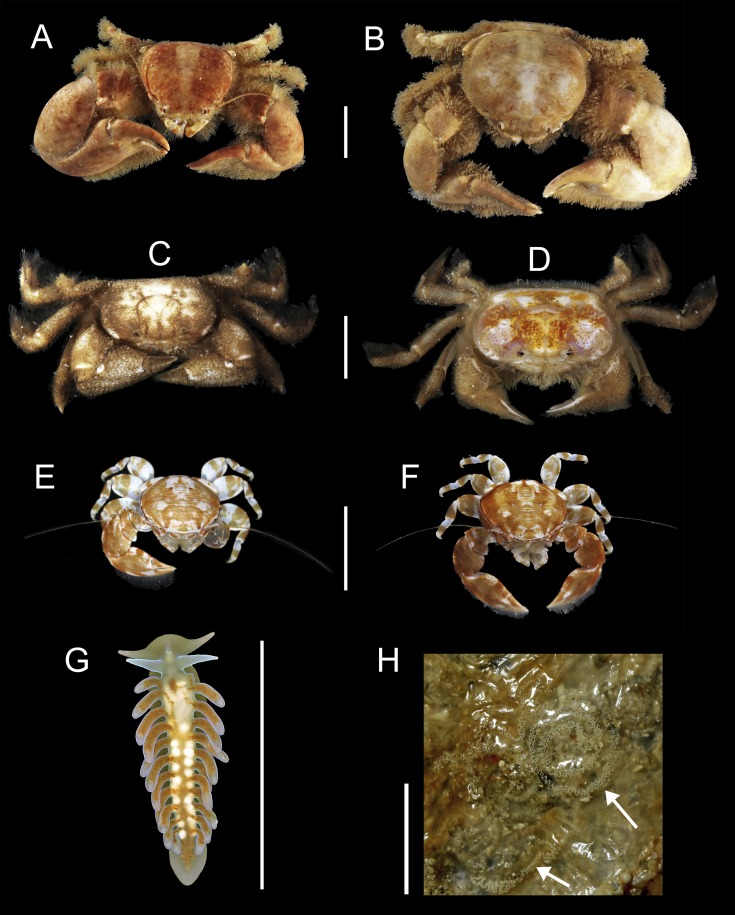
Symbiotic species associated with Chaetopterus sp.: (A, B) Polyonyx cf. heok (male and female, respectively); (C, D) Tetrias sp. (male and female, respectively); (E, F) Polyonyx sp., (male and female, respectively); (G, F) Phestilla sp. (whole body and egg-mass, respectively); egg-mass indicated by arrows.Scale bars are 0.5 cm.